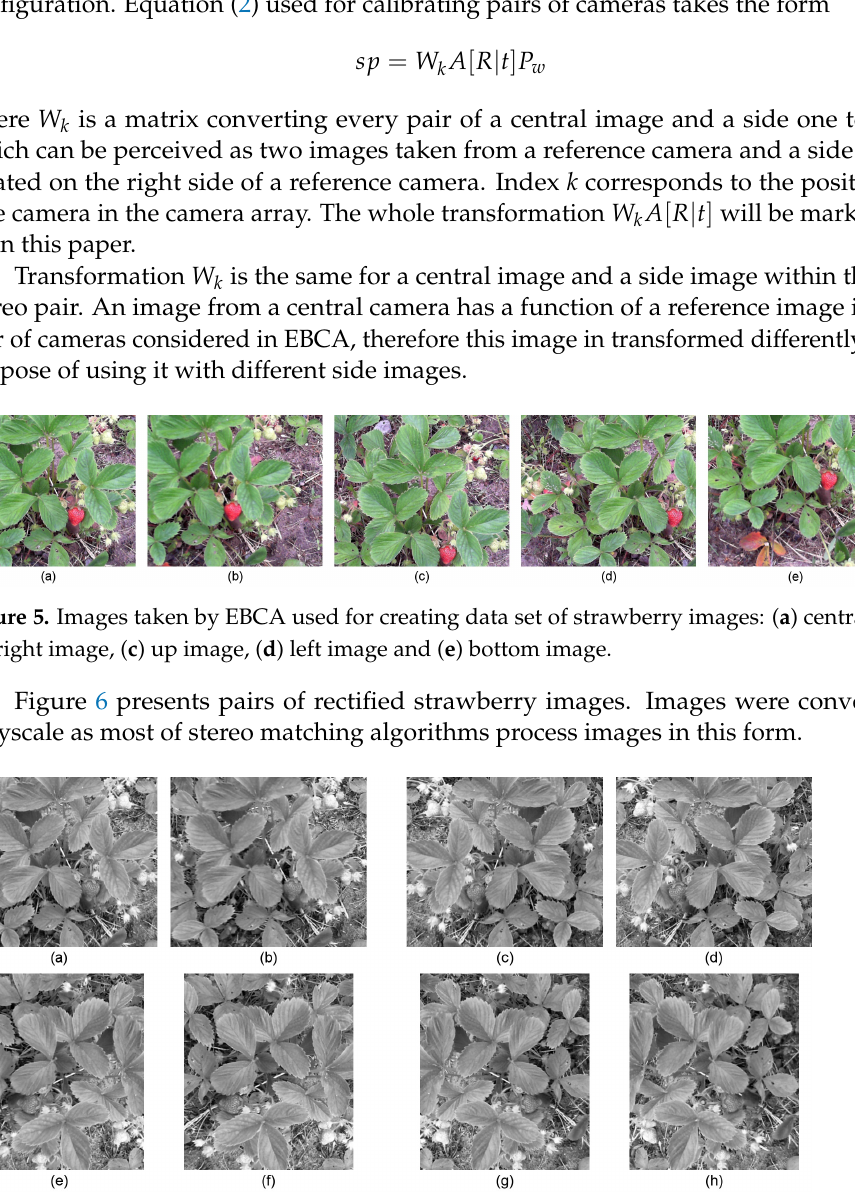
Figure 6. Pairs of images in strawberry data set ST 1 after performing the calibration process. ( a , b ) The left pair, ( c , d ) The up pair. ( e , f ) The right pair. ( g , h ) The bottom